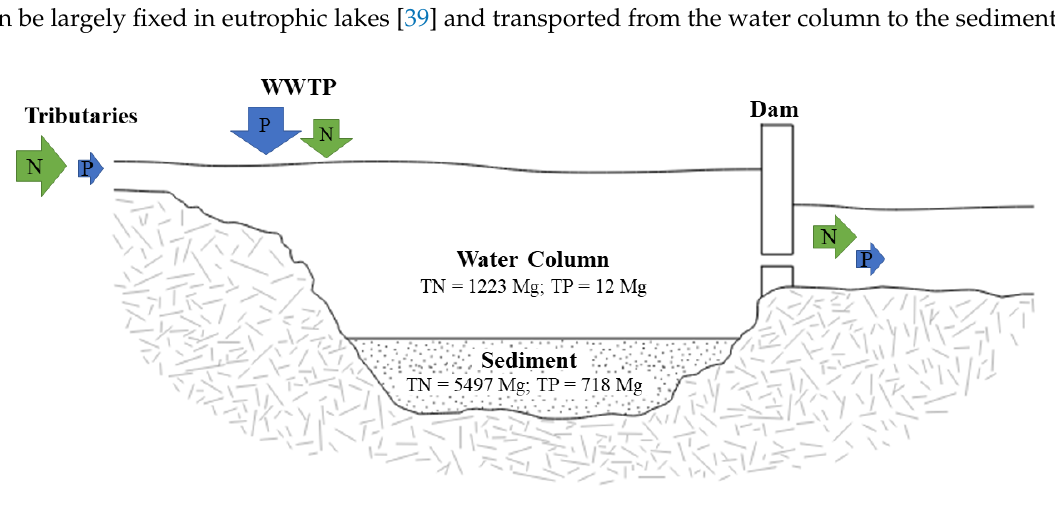
Figure 4. Storage of N and P in Lake Paranoá.